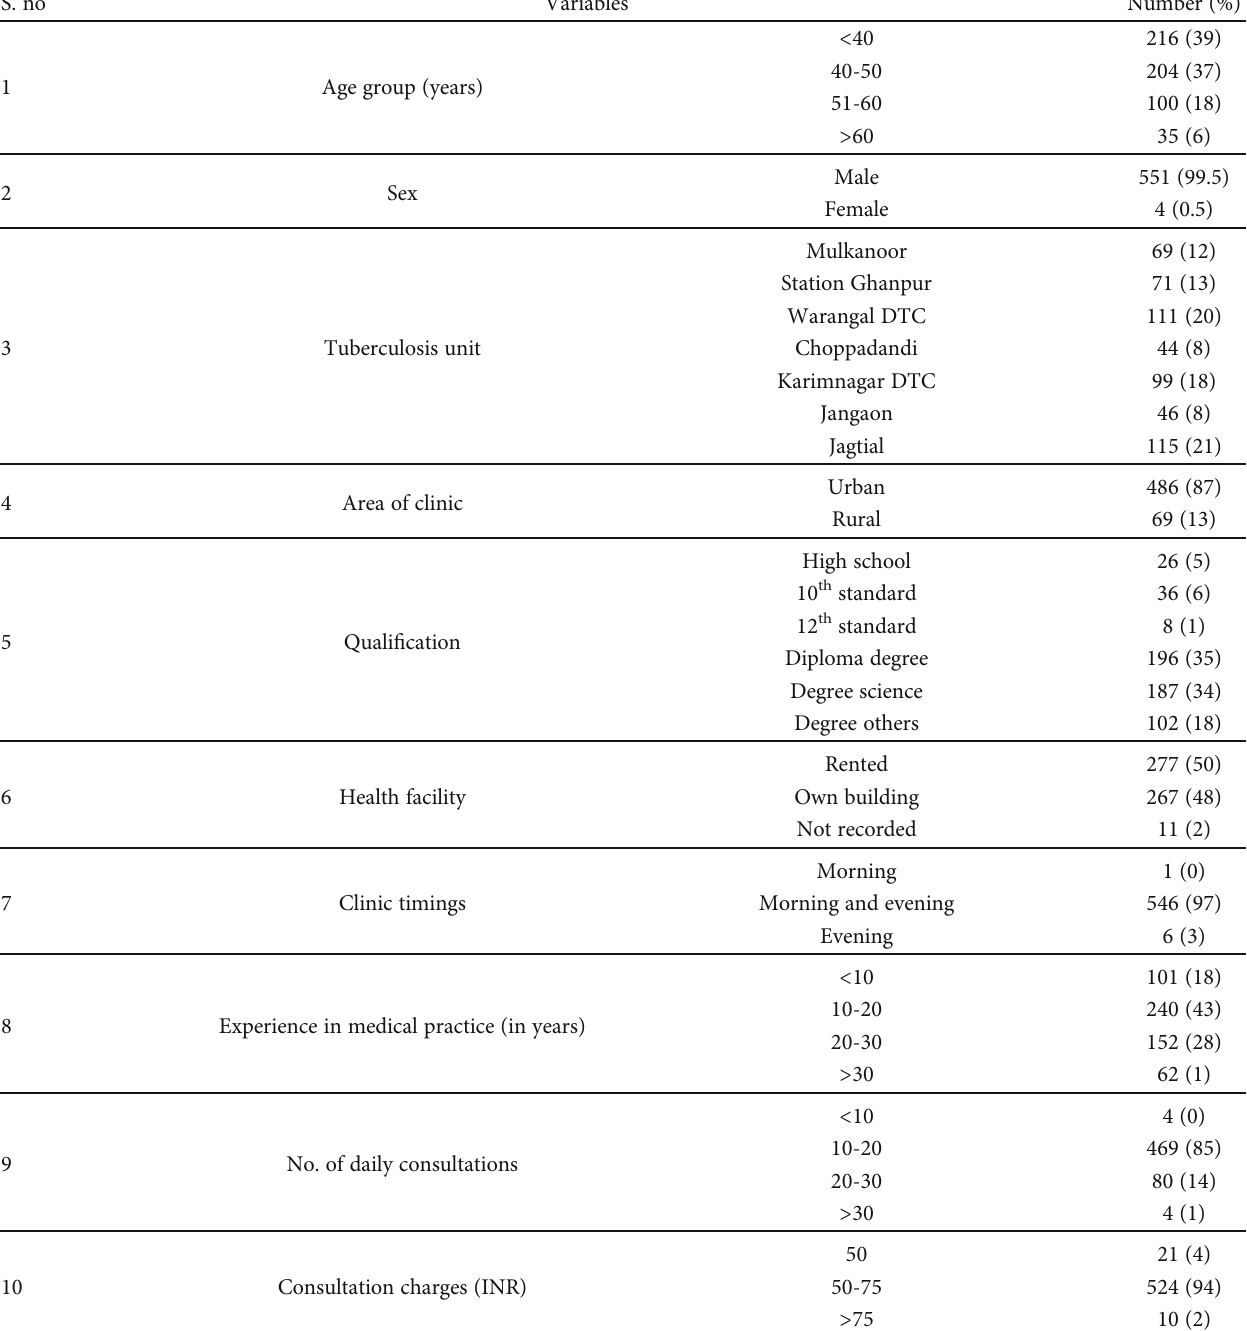
Table 1: Sociodemographic characteristics of informal providers involved in RIPENED project, Telangana State, India, 2018-19 ( N = 555 ). S.